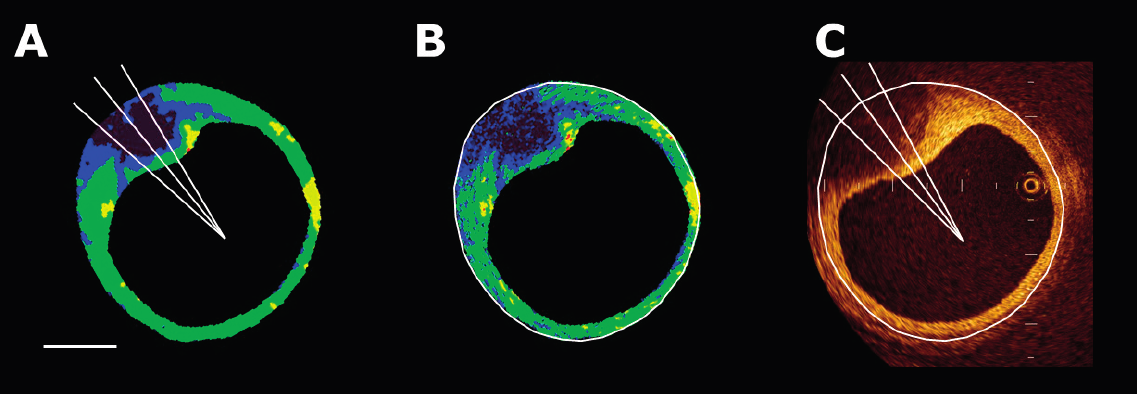
Figure 5. Representative images of coronary plaques. ( A ) IB-IVUS images processed by a smoothing method; ( B ) Original IB-IVUS images; ( C ) Corresponding optical coherence tomography images. Scale bar = 1 mm.